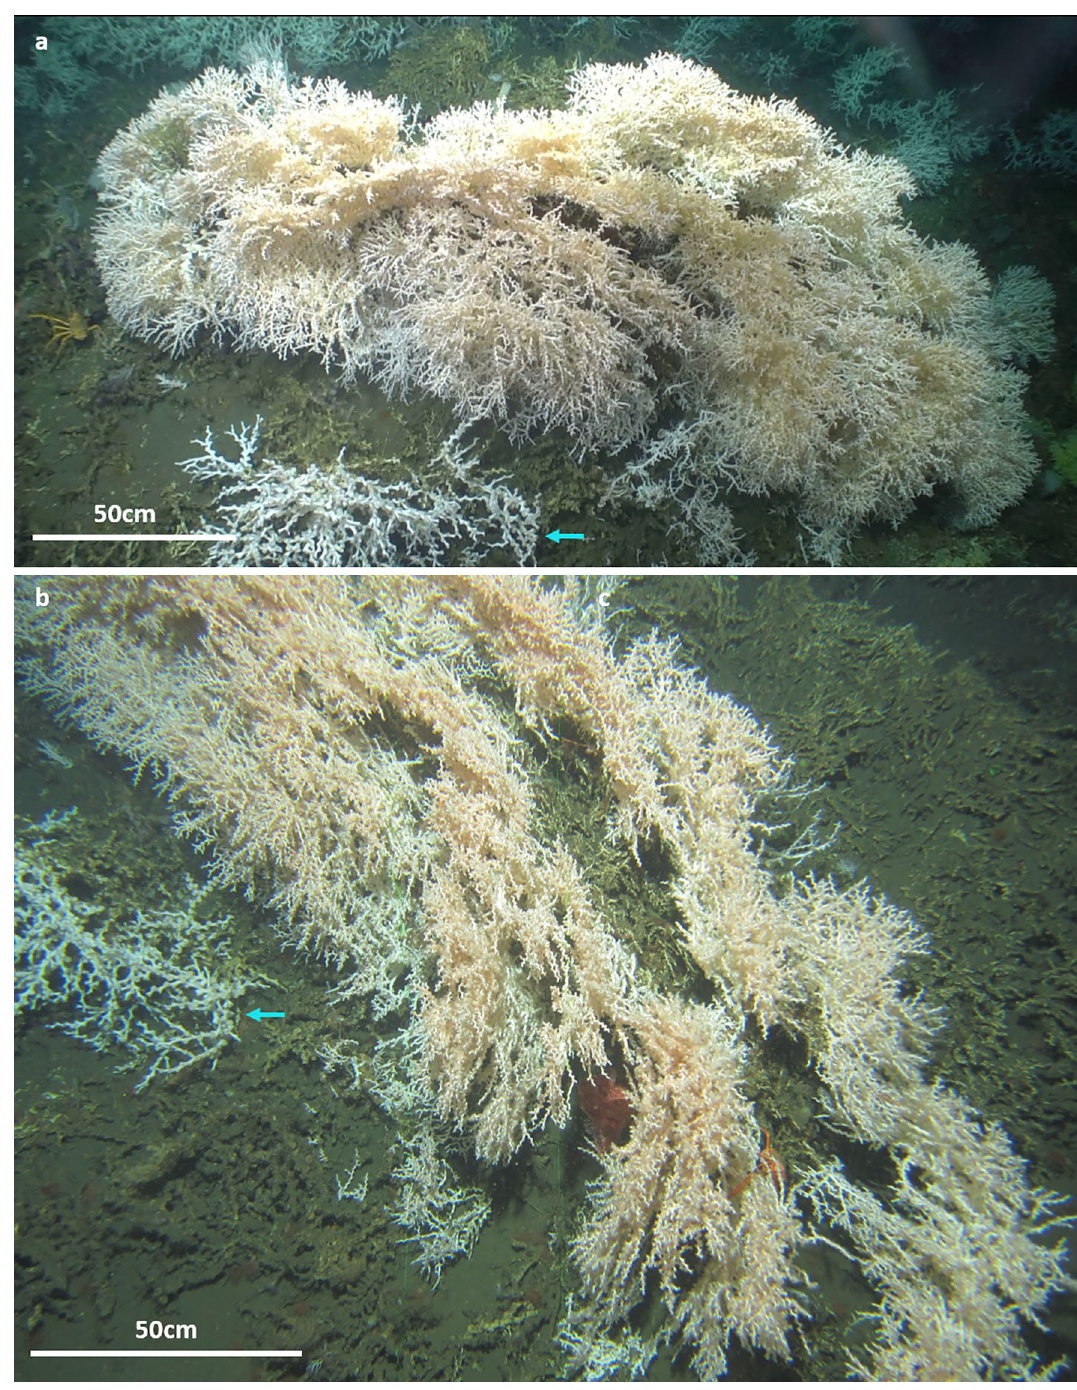
Figure 4. Extraordinary large Madrepora oculata framework of 1.2 m height observed on the Scary mound off Angola. ( a ) Panoramic view of the coral framework. ( b ) Zenithal view of the coral structure showing the different growing layers of the framework. Blue arrows indicate the Lophelia pertusa colonies in the vicinity of the large M. oculata framework. Credits: photographs by MARUM ROV